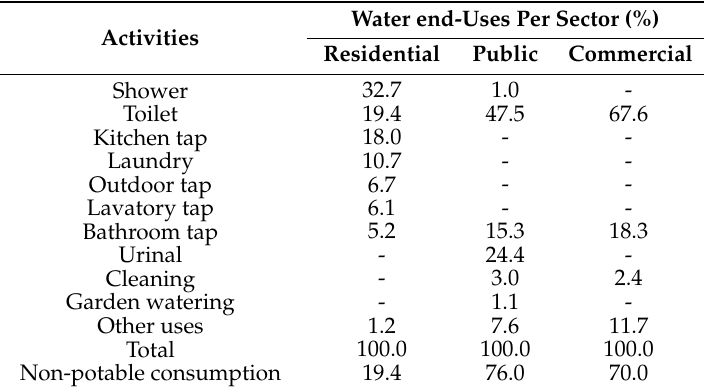
Table 10. Water end-uses per sector in Florianópolis.